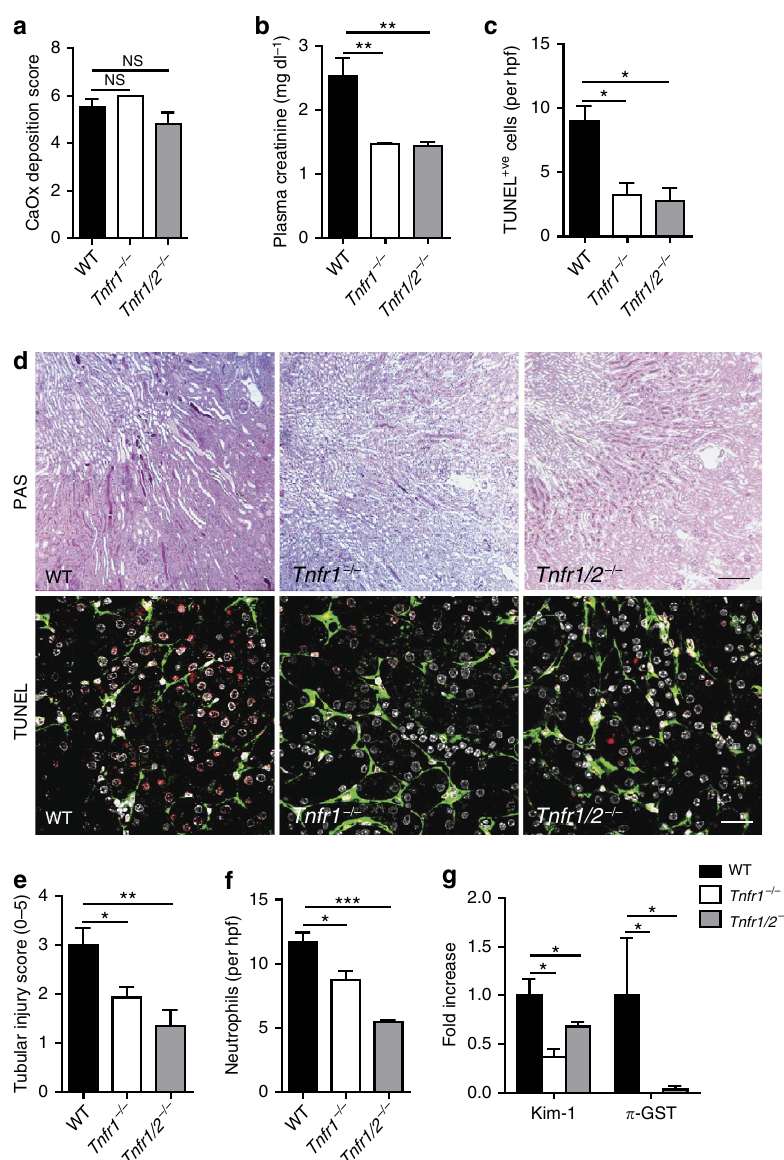
Figure 7 | Oxalate nephropathy in C57BL/6 mice requires TNFR1. ( a ) Oxalate injection to wild-type mice as well as to Tnfr1 - and Tnfr1/2 -deficient mice of the same genetic background ( n ¼ 5 in each group) resulted in identical amounts of CaOx crystal deposition after 24h as quantified by morphometry of Pizzolato-stained kidney sections. ( b , c ) Oxalate nephropathy in wild-type mice was associated with increased plasma creatinine levels ( b ) and